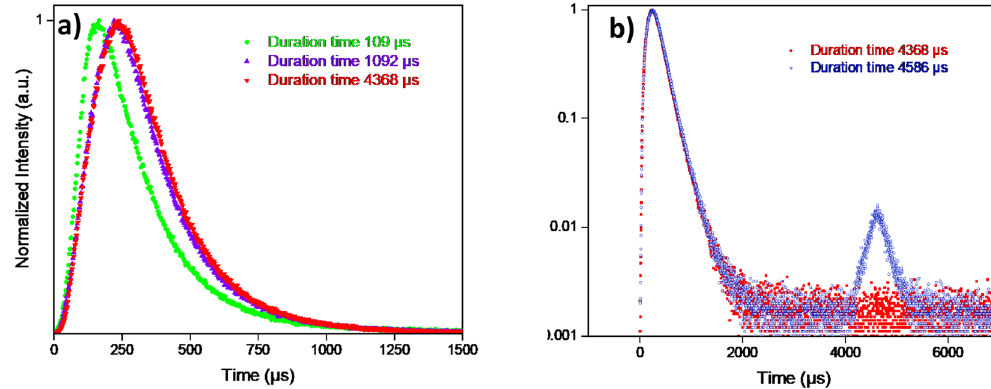
Figure 5. ( a ) Time evolution of upconversion photoluminescence intensity measured under four different excitation duration times (109 µ s 1092 µ s , 4368 µ s , respectively) of the pulsed laser. We observed the dynamic picture of rise time versus excitation duration for 30% Gd 3 + doped NaYF 4 sample. We fitted the values of decay lifetimes and rise lifetimes by using algorithm in DAS6 Analysis software, which allows deconvolution analysis of time-domain luminescence data with two exponentials. ( b ) Time evolution of upconversion photoluminescence intensity measured under two different excitation duration times (4368 µ s and 4586 µ s , respectively) of the pulsed laser. The temporal evolution of the photoluminescence of NaYF 4 as a function of time can be described by a Vial’s type equation 32 .